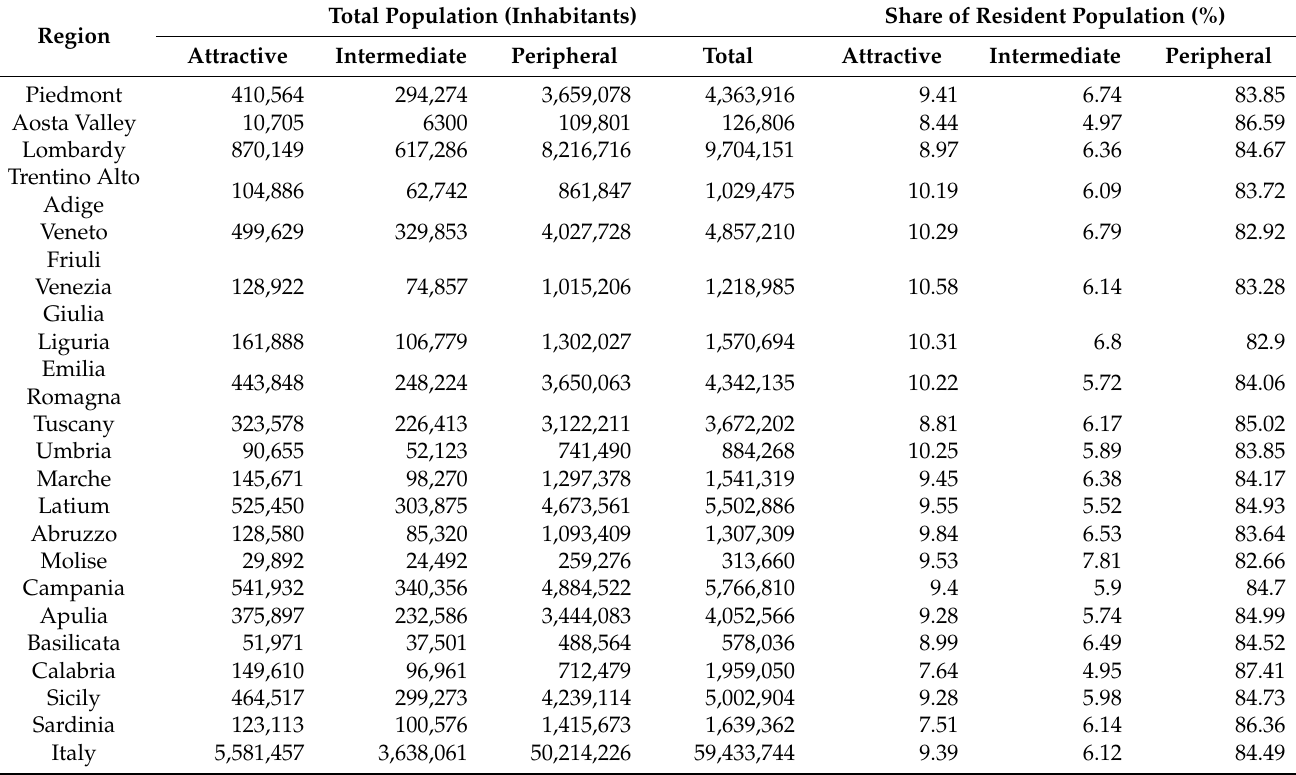
Table 1. Spatial distribution of resident population in Italy by region and centrality level based on the original ISTAT index of centrality (Section